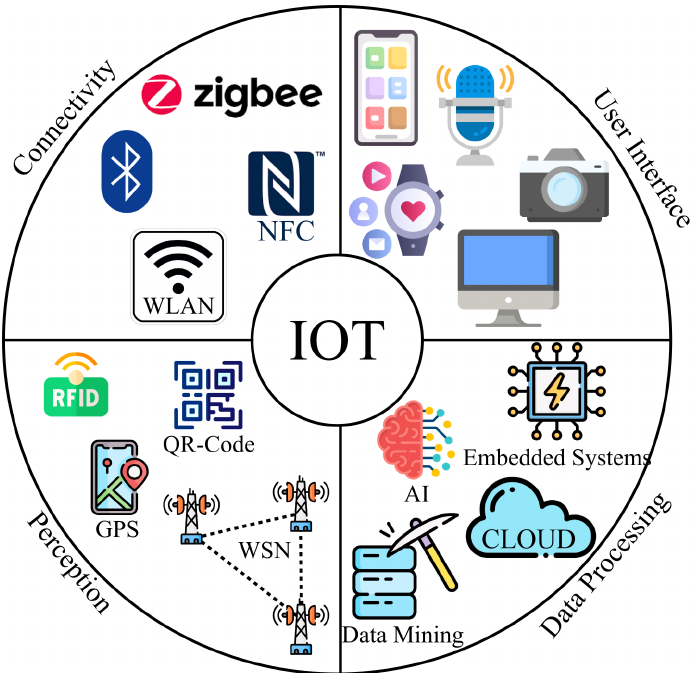
Figure 4. Components of IoT